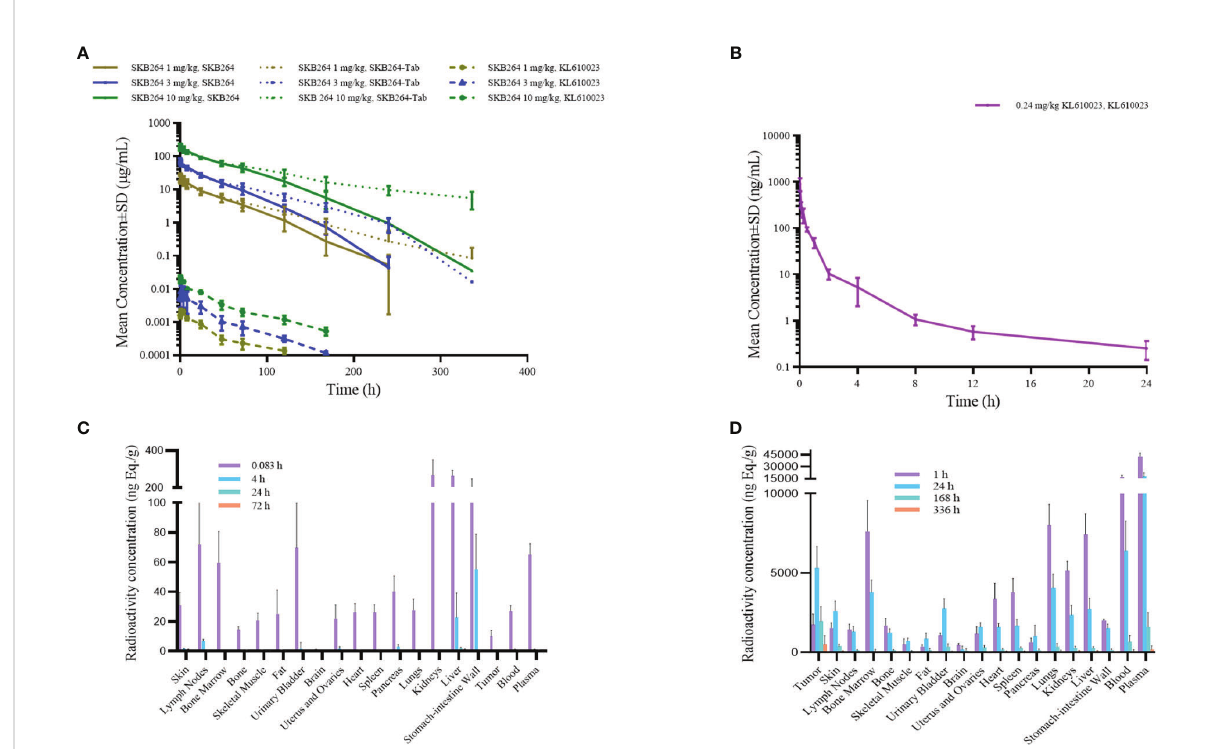
FIGURE 6 (A) Mean serum concentration – time curve of SKB264 (at different doses), Tab, and KL610023 following single administration (i.v.) of SKB264 in cynomolgus monkeys ( n = 6/group). (B) Mean serum concentration – time curve of KL610023 following single administration (i.v.) of KL610023 in cynomolgus monkeys ( n = 6). (C) Total radioactivity (TRA) in blood, plasma, and normal tissues following a single intravenous dose of [ 3 H] KL610023 at 0.1 mg/100 µCi/kg in xenografted nude mice ( n = 6). (D) TRA in blood, plasma, and normal tissues following a single intravenous